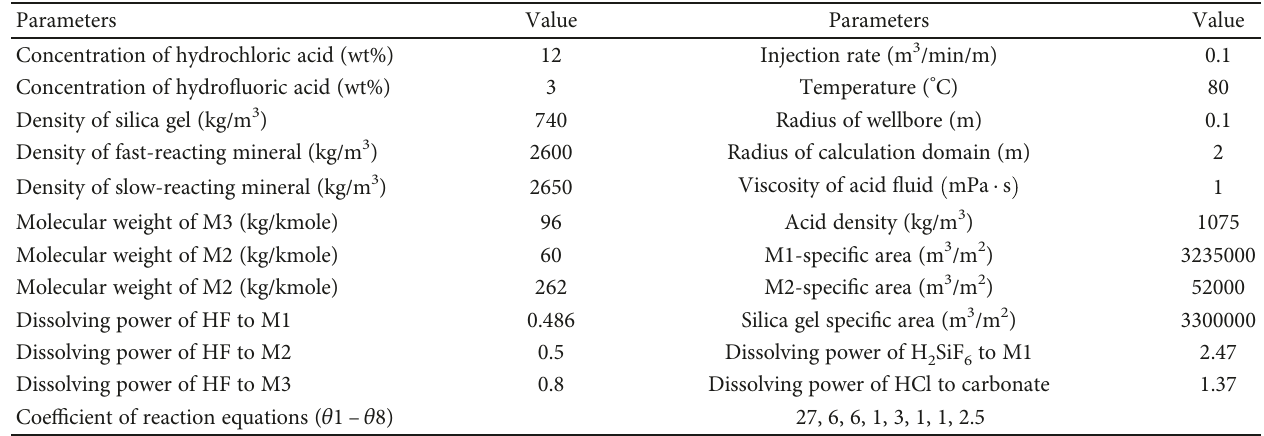
) of fast-reacting and slow-reacting minerals. j Table 1: Model parameters.